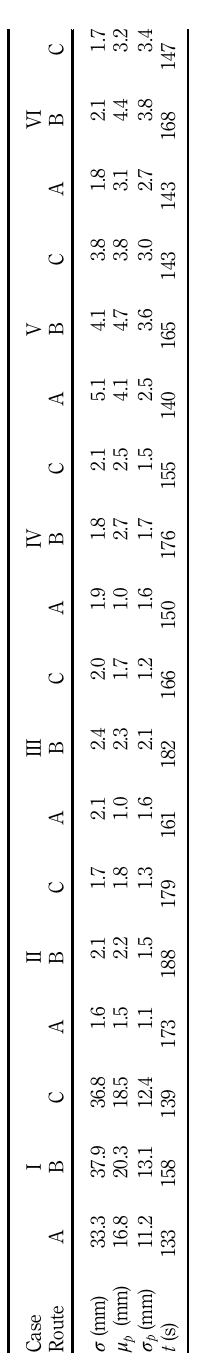
Table 2. Average deviation distributionofdifferent navigation